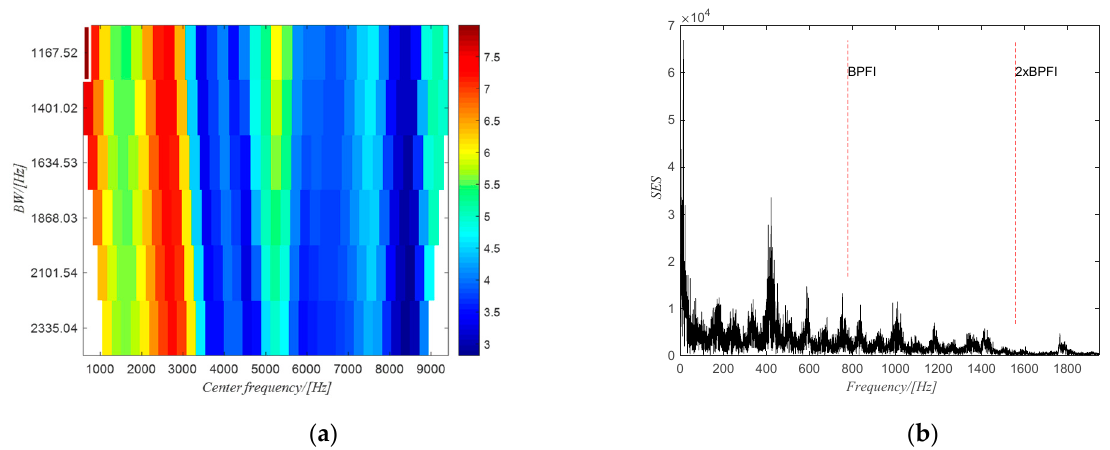
Figure 24. ( a ) The PMFSgram of the raw signal; ( b ) the SES of the filtered signal.